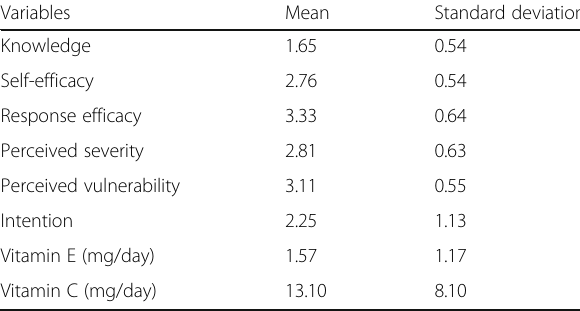
Table 1 Means and standard deviation of PMT constructs ( N = 420) Variables Mean Standard